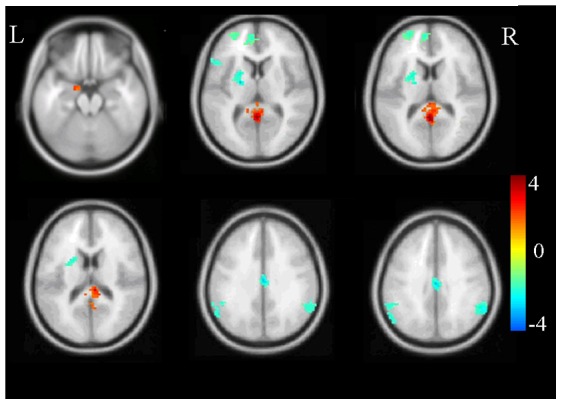
Group comparison in the negative-enhance condition.A warm color indicates increased activation, and cold color indicates decreased activation. The color bar indicates T-score. L:left, R:right.